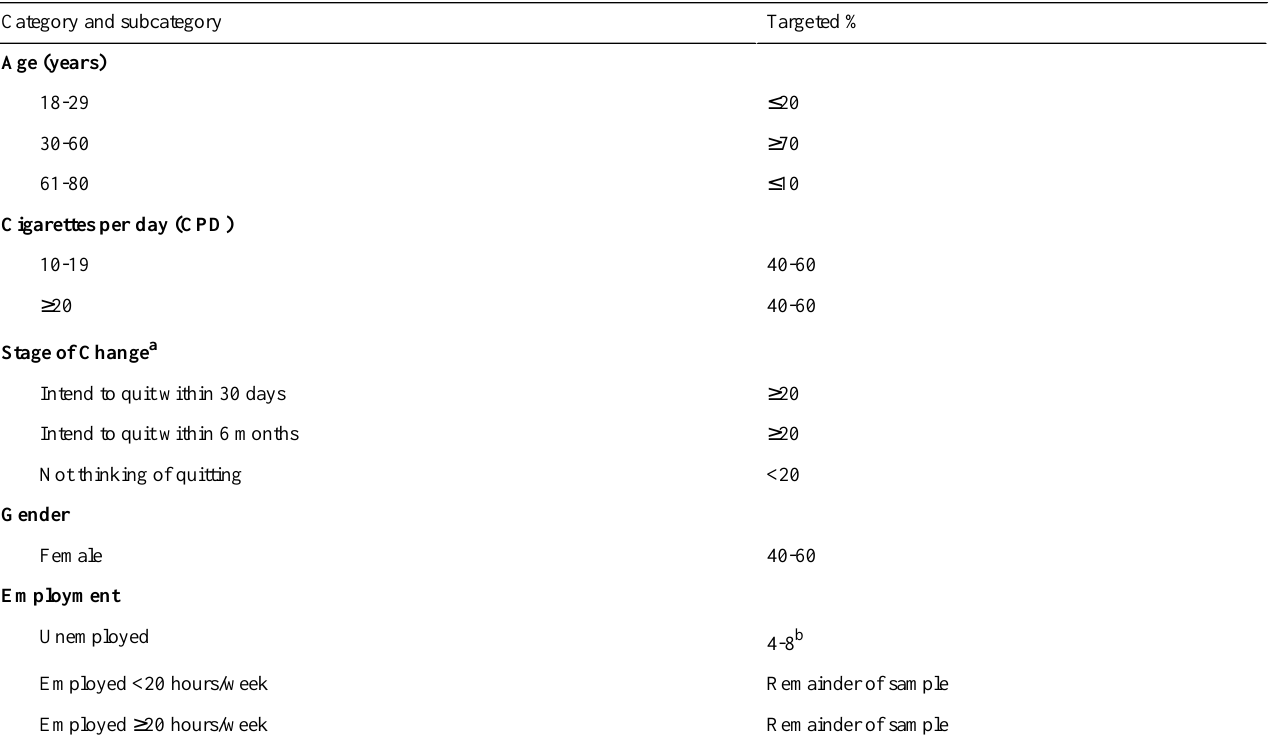
Table 1. Nonproportional quota sampling enrollment: targeted